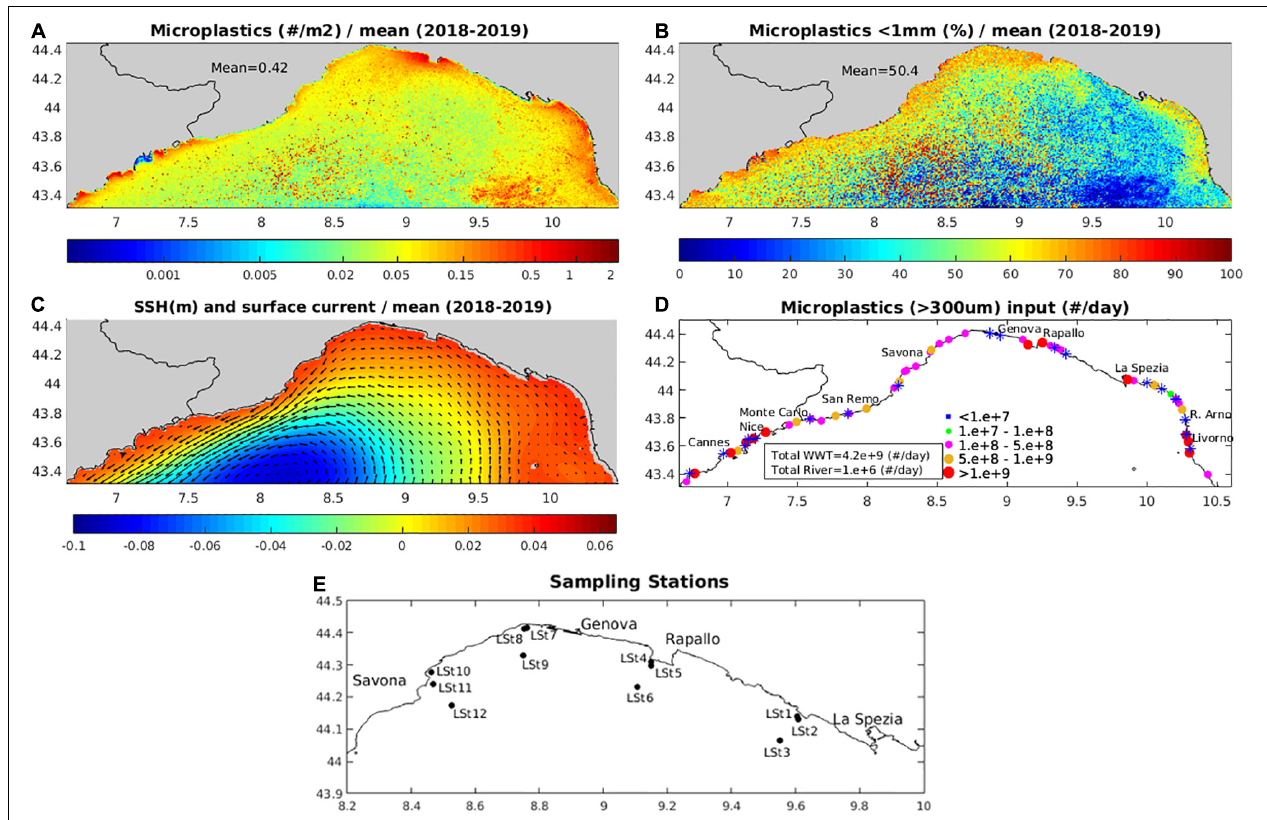
FIGURE 4 | Mean (2018–2019) simulated (A) microplastics concentration (items/m 2 ) (B) microplastics < 1 mm (%), (C) surface current and sea surface height (m) and (D) sources of microplastics (items/day) from cities wastewater discharge and river runoff, (E) sampling stations in the Ligurian Sea.